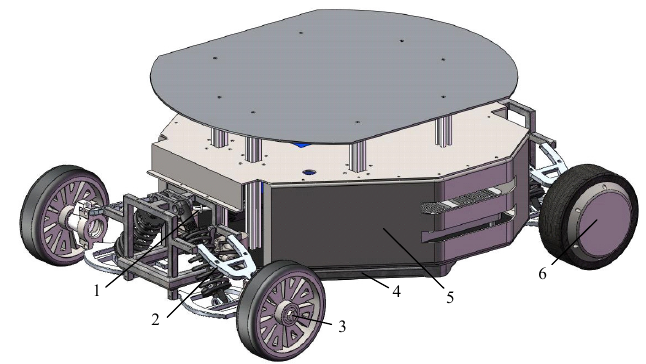
Figure 10. Simulation design diagram of the tomato picking robot chassis. 1: Steering mechanism; 2: suspension mechanism; 3: driven wheel; 4: frame; 5: car shell; 6: driving wheel.